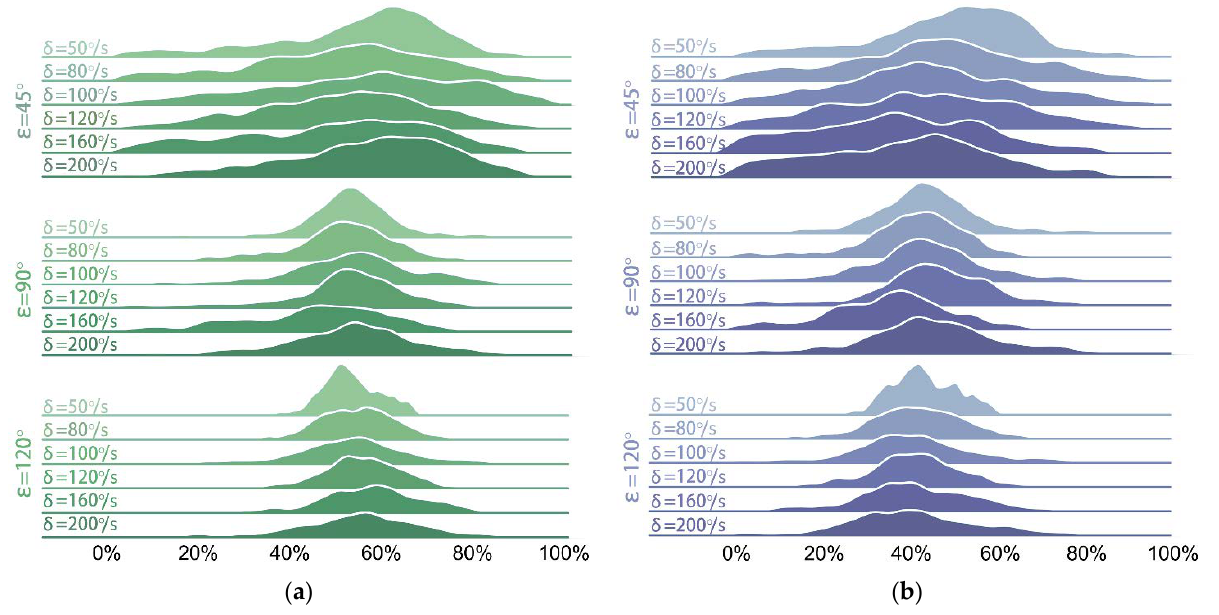
; ( b ) . Figure 9. Distributions of balance efficiencies of REF19 under 18 conditions: ( a ) η CG ; ( b ) η PF 𝜂𝜂 𝐶𝐶𝐶𝐶 𝜂𝜂 𝑃𝑃𝑃𝑃